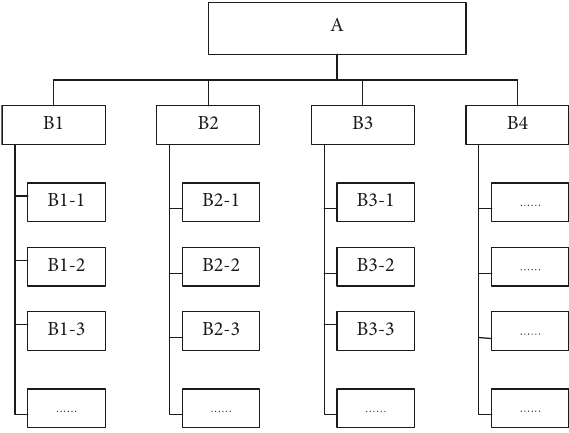
Figure 3: Flow space planning model of classical